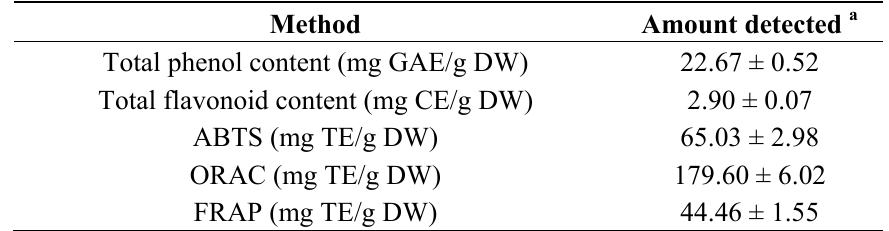
Table 2. Polyphenol and flavonoid content and antioxidant activity of perilla